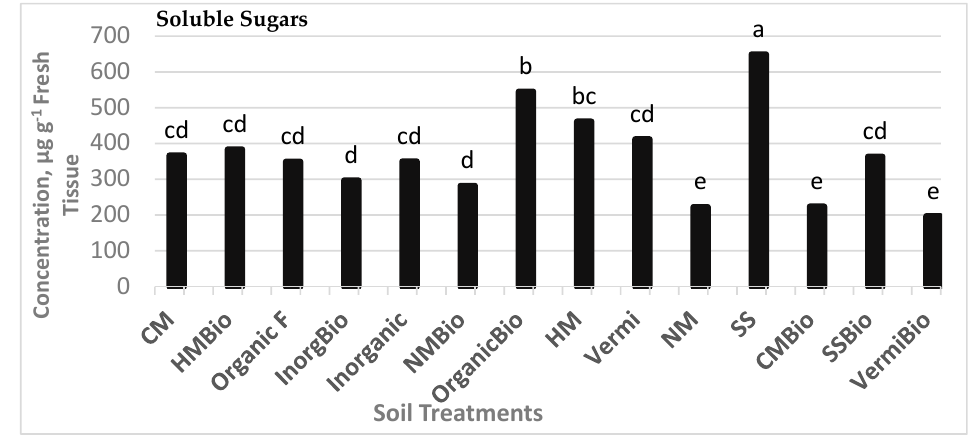
Figure 5. sugars concentrations in tomato grown in soils amended with: Vermicompost (Vermi), no ‐ mulch soil mixed with biochar (NMBio), inorganic fertilizer (Inorganic), sewage sludge mixed with biochar (SSBio), vermicompost mixed with biochar (VermiBio), inorganic fertilizer mixed with biochar (InorganicBio), chicken manure mixed with biochar (CMBio), horse manure mixed with biochar (HMBio), chicken manure (CM), horse manure (HM), organic fertilizer mixed with biochar (OrganicBio), sewage sludge (SS), no ‐ mulch bare soil (NM), and organic fertilizer (Organic). Values accompanied by the same letter(s) are not significantly different ( p > 0.05).